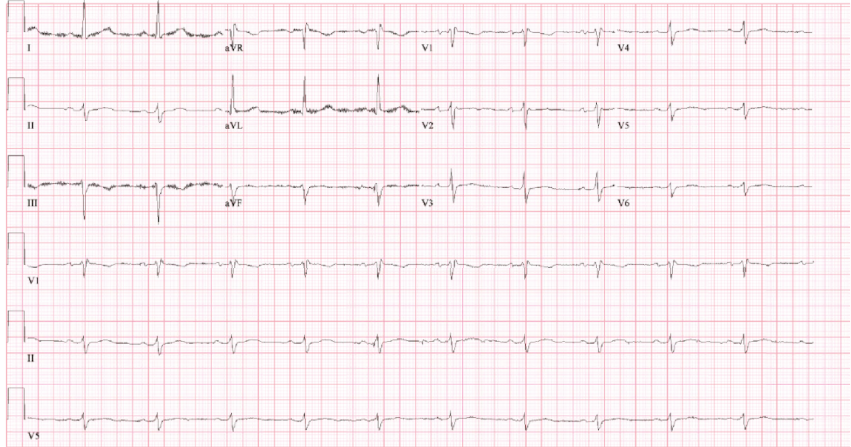
Figure 2: Resolution of BrS Type I ECG